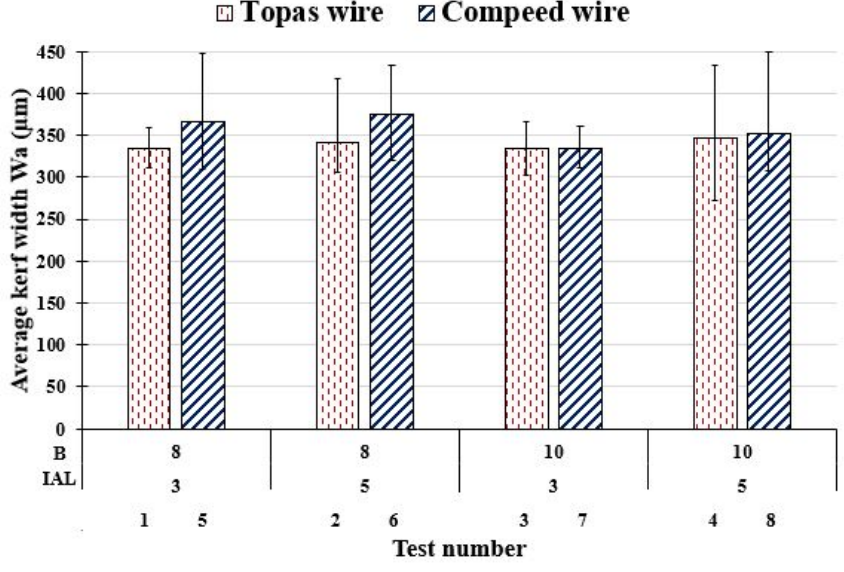
Figure 9. Average kerf width in each test for the Topas and Compeed wire electrodes.